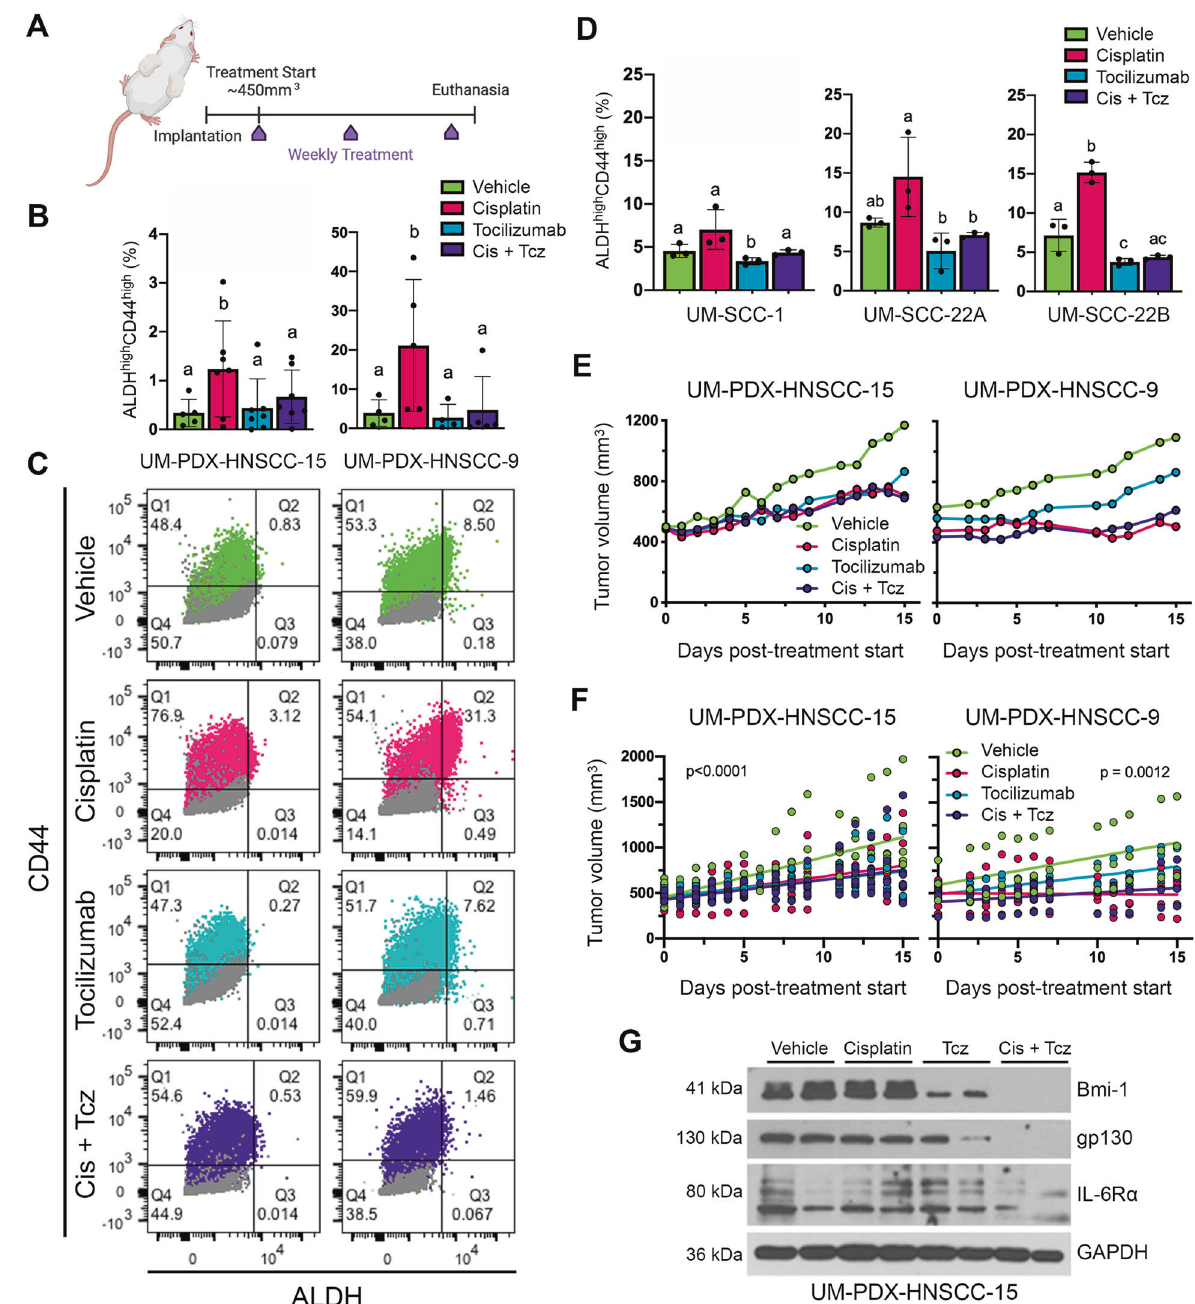
Fig. 2 Tocilizumab suppresses Cisplatin-induced stemness in PDX models of HNSCC in vivo. A Schematic drawing depicting study design. Mice harboring PDX tumors began weekly treatment for 2 weeks (3 doses total), receiving either no treatment, Cisplatin (5 mg/kg, i.p.), and/or Tocilizumab (10 mg/kg, i.p.). Mice were killed 2 days after last dose. B Bar graphs depicting percentage of CSCs (ALDH high CD44 high cells) in PDX tumors, as measured by fl ow cytometry. Different lowercase letters indicate statistical signi fi cance at p < 0.05. C Representative fl ow cytometry charts depicting DEAB/IgG controls (gray) for Alde fl uor (ALDH activity) and CD44 expression. One experimental replicate per group is shown to demonstrate gate-setting strategy. ALDH high CD44 high cells were identi fi ed based on these gates. D Bar graphs depicting the percentage CSCs (ALDH high CD44 high cells) in HNSCC cell lines, as determined by fl ow cytometry. Bar graphs display mean ± SD ( n = 3). Different lowercase letters indicate statistical signi fi cance at p < 0.05. E Line graph depicting mean tumor volume over time in the PDX models after treatment with Cisplatin and/or Tocilizumab. Tumor measurements were taken three times per week until study endpoints. F Simple linear regression model of mean tumor volumes over the duration of the experiment. G Western blottings of representative PDX tumor tissue lysates from each treatment pluripotent stem cell markers as compared to controls (Fig. 3D To determine whether the anti-stemness effect of Tocilizumab and Supplementary Fig. S3B), suggesting that this therapeutic was speci fi c to Bmi-1 or also affected other stemness pathways, strategy may broadly suppress stemness phenotypes in HNSCC. To we used a stem cell protein array. Combination therapy with verify these results, we analyzed protein expression of Oct4 and Tocilizumab/Cisplatin decreased the expression of several